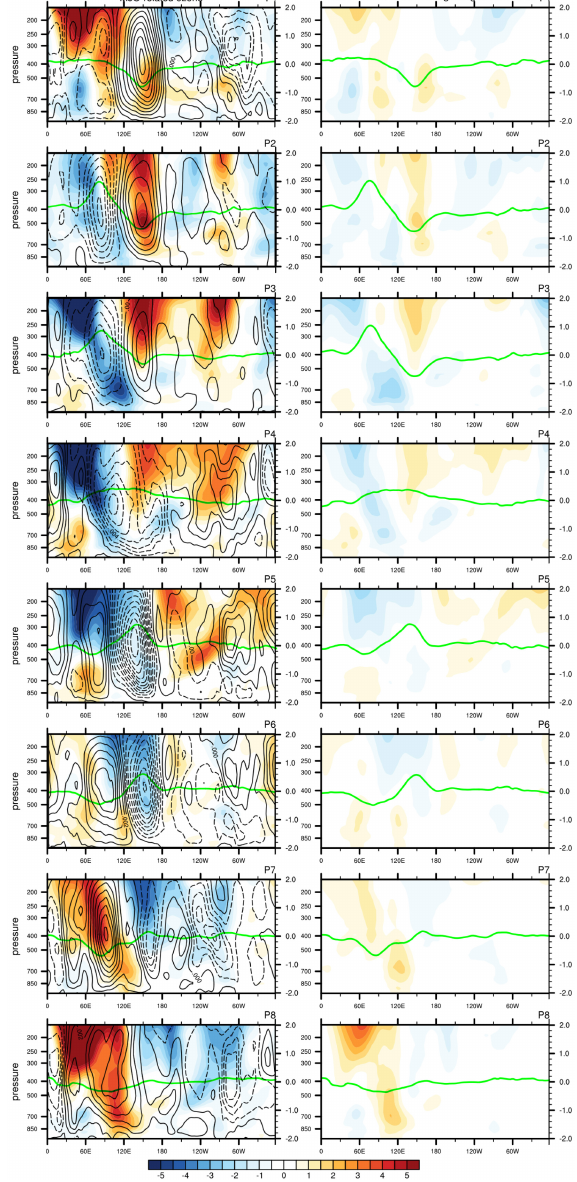
Figure 7. Left: MJO-related ozone anomalies (color, in ppb) with GEOS-5 vertical velocity (dashed black lines as negative and solid black lines as positive) and precipitation (green lines, in mmday − 1 ) for the control run; right: MJO-related ozone anomalies (color, in ppb) and precipitation (green lines, in mmday − 1 ) for the run with lightning NO turned